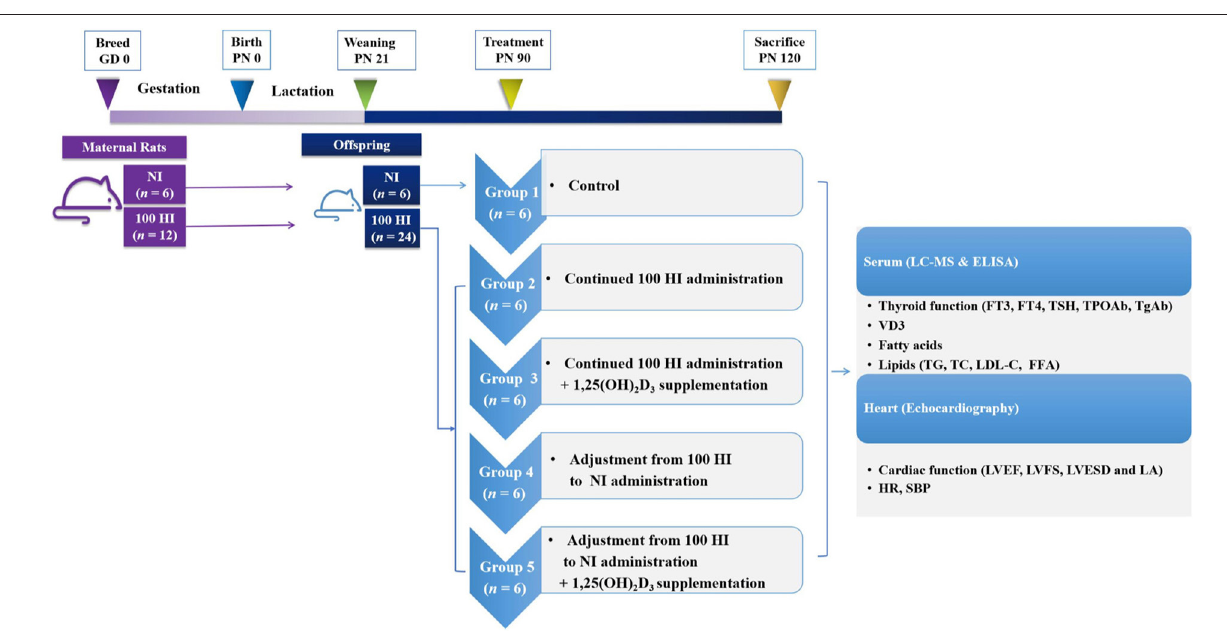
FIGURE 2 | Study plan and